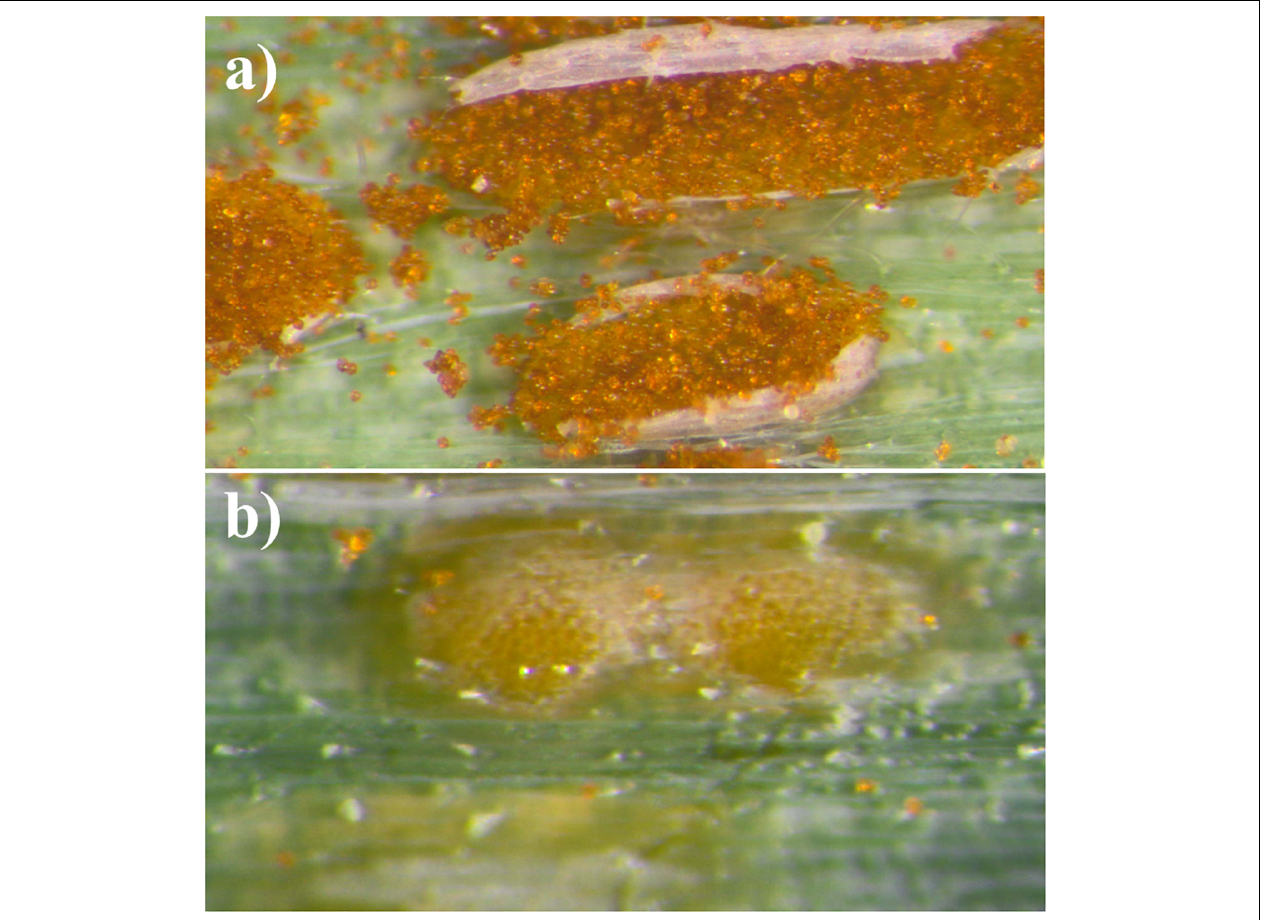
FIGURE 4 | Symptoms of (a) leaf rust and (b) stripe rust observed on leaves of triticale “Sekundo.”